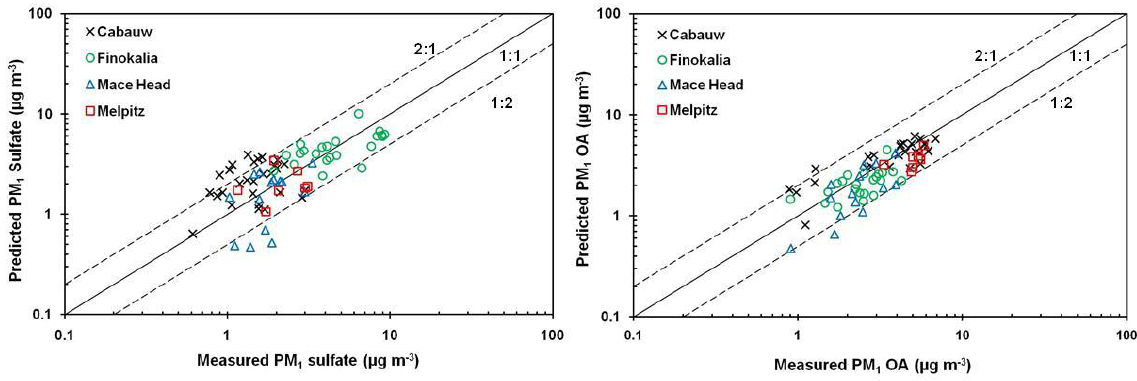
Fig. 17. Comparison of predicted versus observed PM 1 sulphate and organic aerosol concentration (µgm − 3 ) from 4 measurement stations during the EUCAARI May 2008 campaign. Each point corresponds to a 24-h average value. Also shown the 1:1, 2:1 and 1:2 lines. Observed data represent AMS